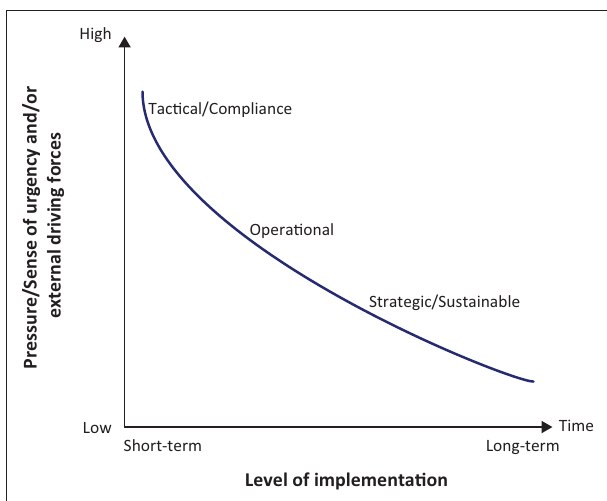
FIGURE 2: Influence of external driving forces on level and time frame of implementation.